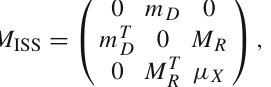
Table 1 Present experimental bounds on Lepton Flavor Violating Z boson decays. Here BR ( Z → (cid:3) k (cid:3) m ) ≡ BR ( Z → ¯ (cid:3) (cid:3) ) + BR ( Z → ¯ (cid:3) k m